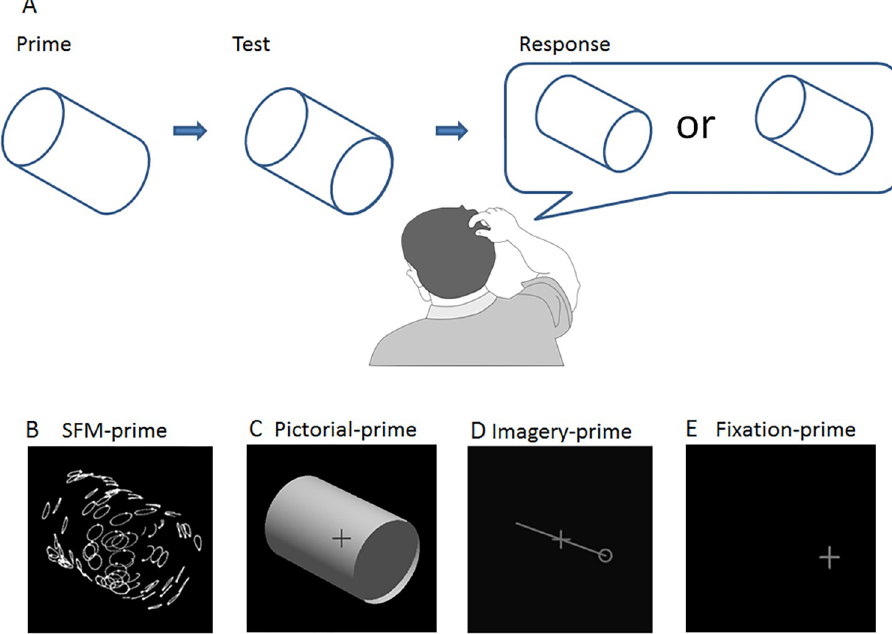
Fig 1. The priming sequence and the primes. A. Priming results in reporting the ambiguous test cylinder as having the same orientation as the stable prime cylinder. In Experiment 1 primes B to E were used and in Experiment 2 primes B to D were used. B. Structure-from-motion prime-cylinder, a non-transparent cylinder where dots are occluded by the near side of the cylinder, displayed with a long exposure showing a complete period of the motion strikes of individual dots. C. The pictorial prime-cylinder, revealed by shading due to illumination from above. D. An example of the imagery prime, with the orientation and opening of the cylinder to be imagined hinted at by the line and the circle. E. Fixation condition where only the fixation cross appeared at one of the openings of the upcoming test cylinder.